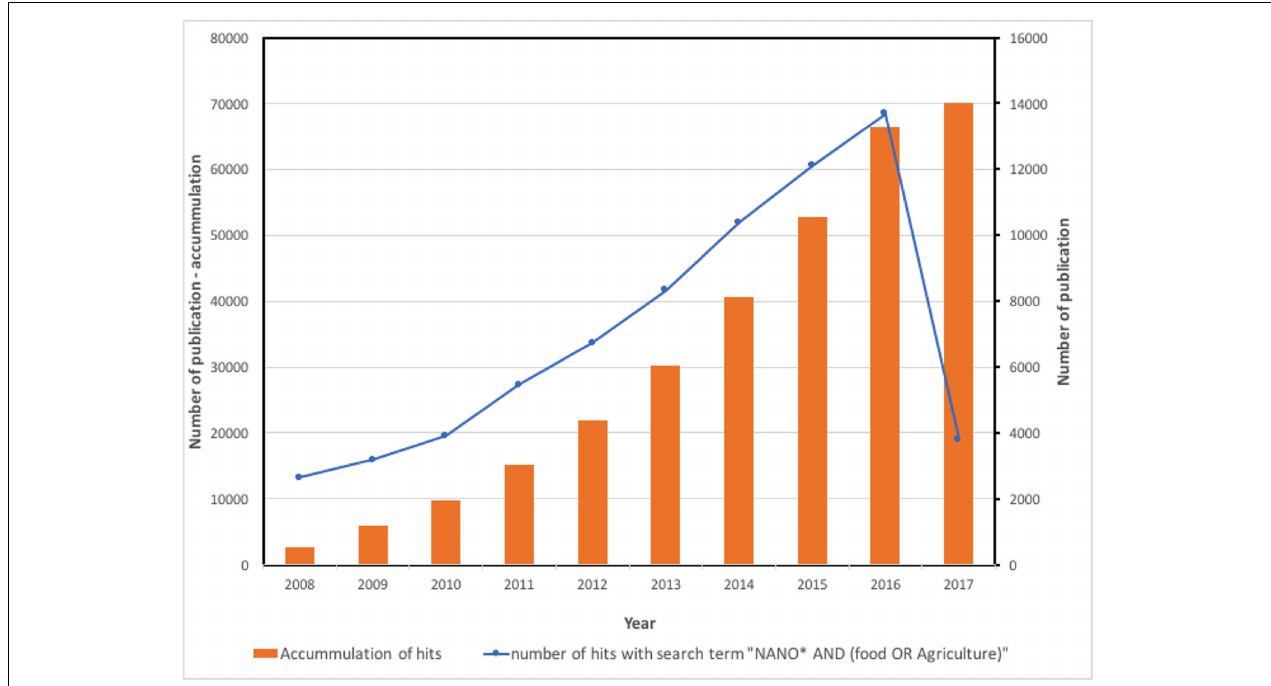
FIGURE 1 | Number of documents on scopus.com with the search term “Nano and (food or agriculture). The hits were grouped annually. Accessed date: March 15, 2017.